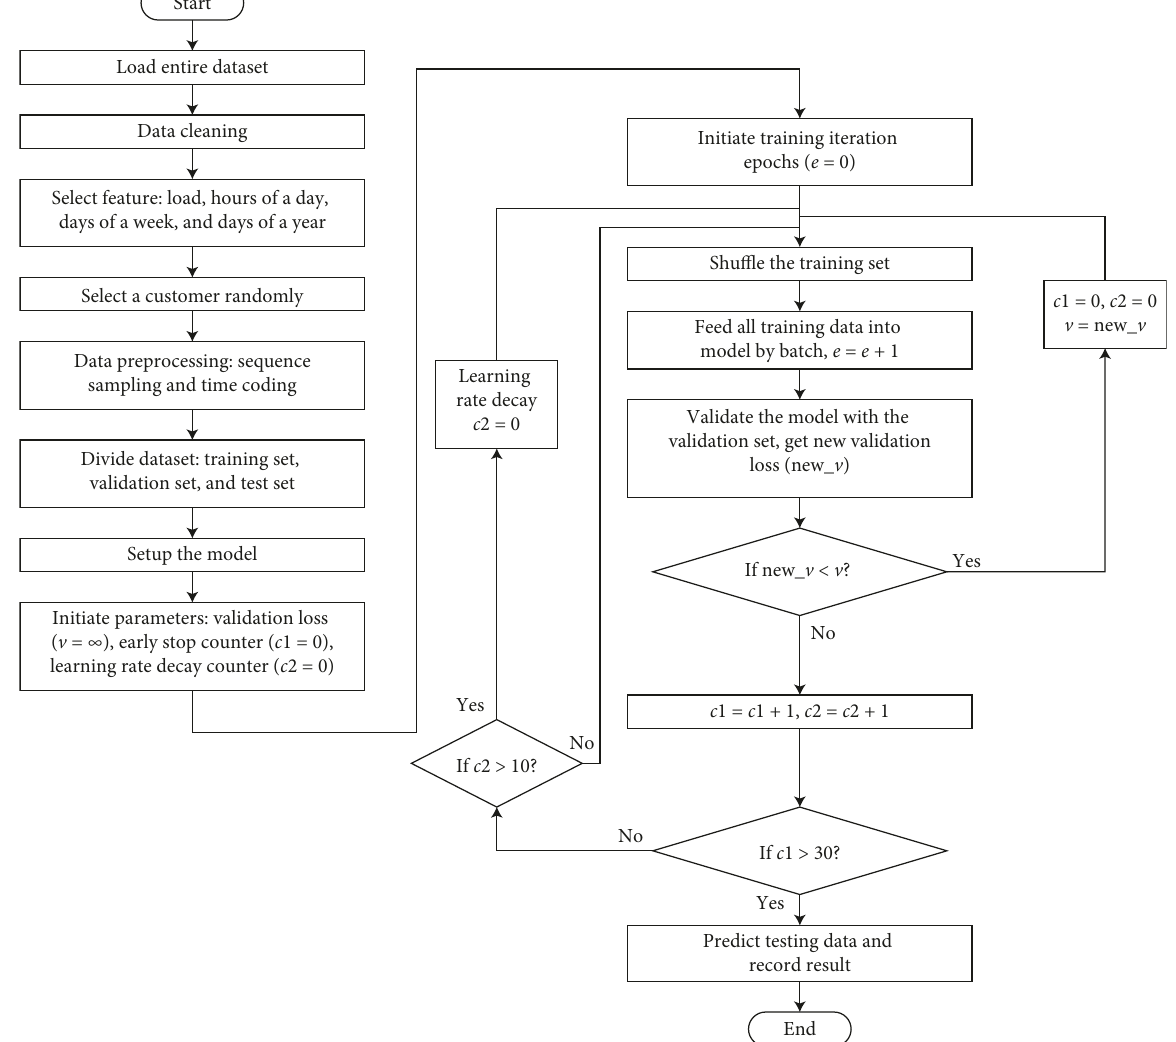
Figure 7: Flowchart for implementation of the proposed